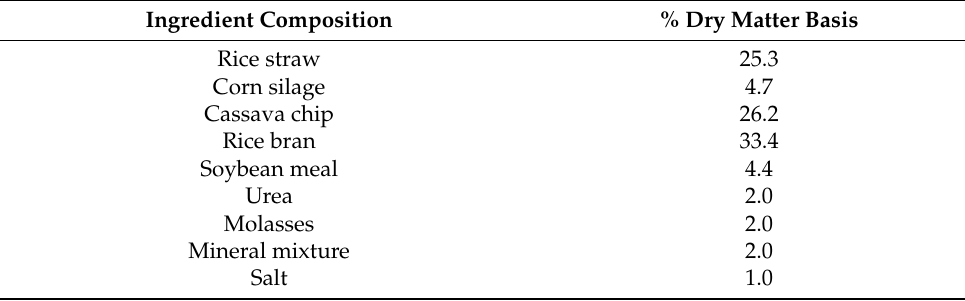
Table 1. Compositions of total mixed